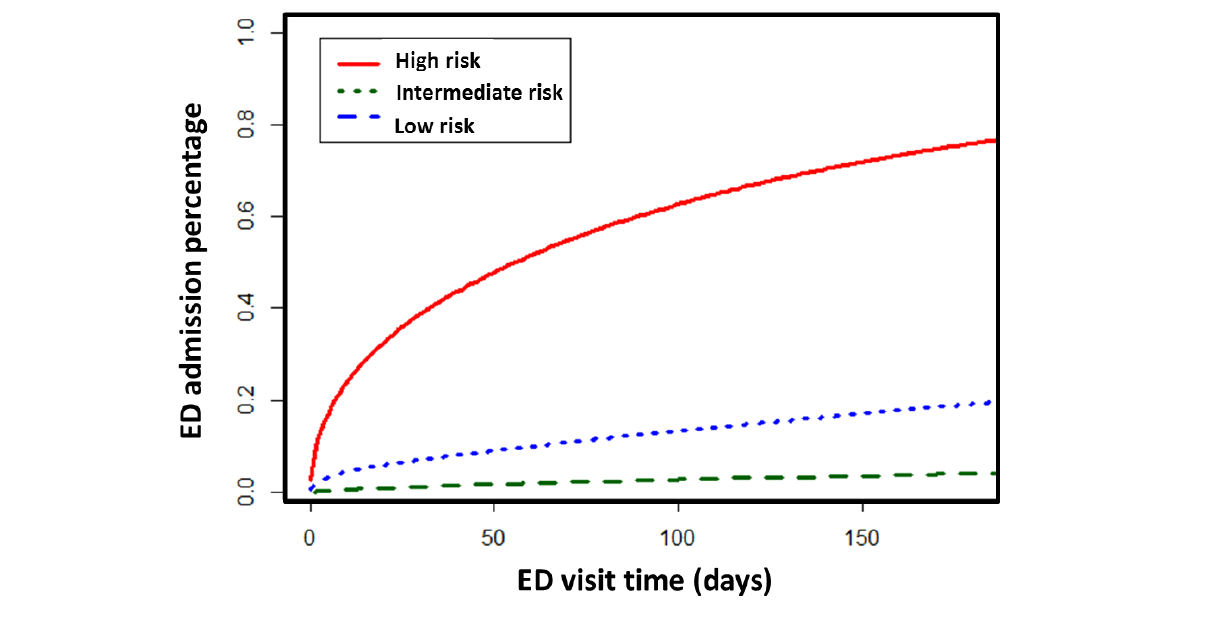
Figure 4. Active case finding algorithm effectively risk-stratified the prospective patient cohort for future 6-month emergency department (ED) visit (graphic representation of low, medium, and high risk patients’time to next impending ED